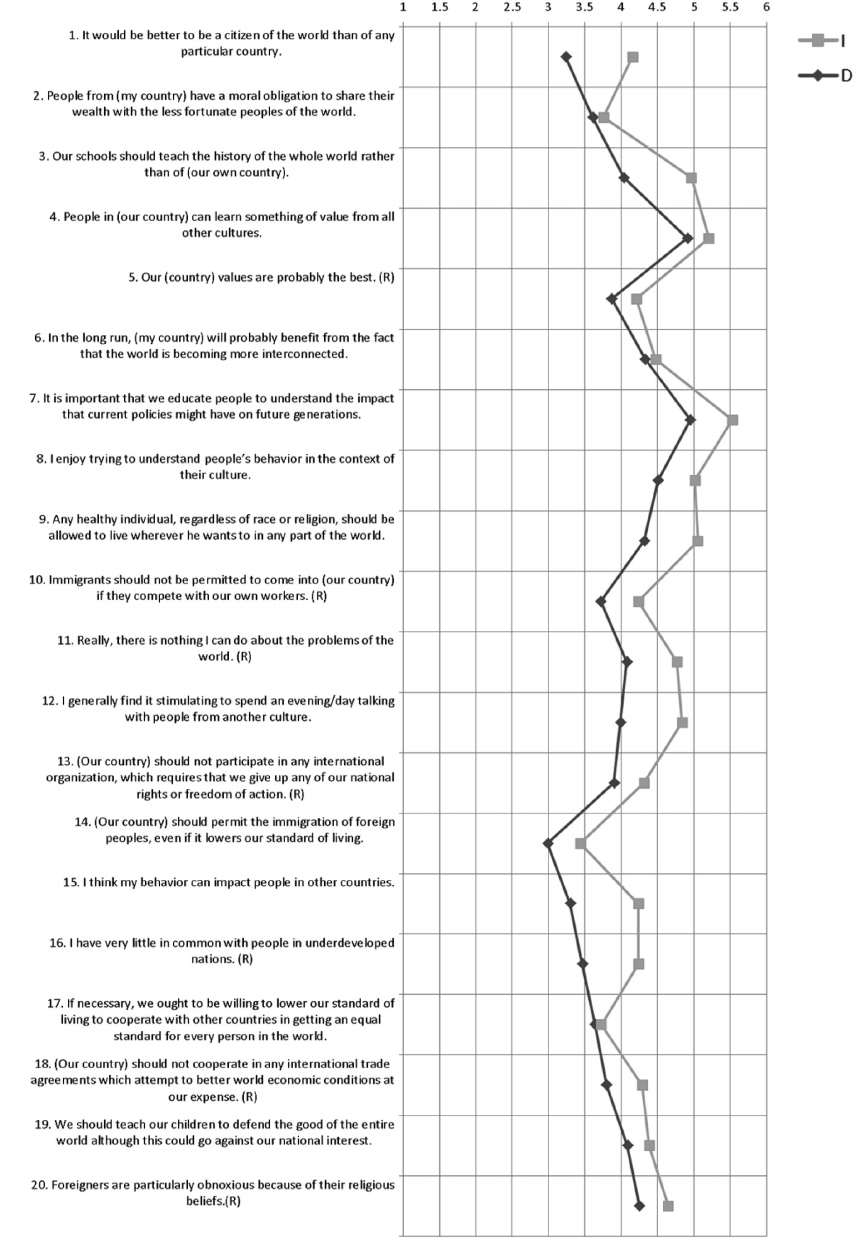
Figure 1: World-mindedness scores of students from regular (D) and international (I) schools in the